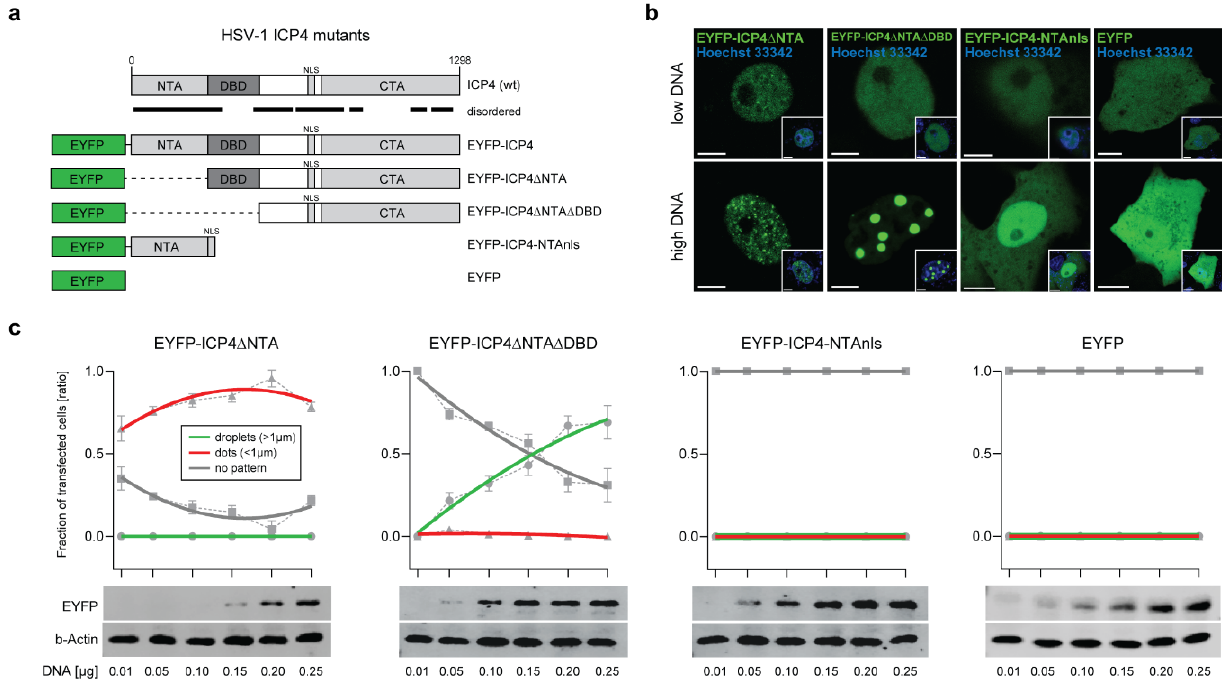
Figure 3. The ICP4 NTA and DBD control the protein phase behavior. ( a ) Schematic representation of the mutant HSV-1 ICP4 constructs used in this study. The plasmid expressing EYFP-ICP4 was used as a positive control and the plasmid expressing EYFP alone was used as a negative control. Disordered regions are indicated with black lines. ( b ) Phase behavior of the mutant ICP4 constructs. Vero cells were transfected with either 0.01 µg (low DNA) or 0.15 µg (high DNA) plasmid DNA expressing the ICP4 constructs described in panel 3a. The cells were counterstained with Hoechst 33342 at 16 hpt (small inset) and subjected to live-cell imaging using CLSM. Representative images for each construct are shown. Scale bars: 5 µm (EYFP-ICP4 constructs) and 10 µm (EYFP). ( c ) Live-cell phase diagrams of the mutant ICP4 constructs. The generation of the protein phase diagrams was performed as described for the EYFP-ICP4 construct (see Figure 1d). The Western blot analysis to detect all mutant ICP4 constructs was performed using a monoclonal antibody against GFP (JL-8) that is capable of detecting EYFP (EYFP). The beta-actin protein levels served as a loading control